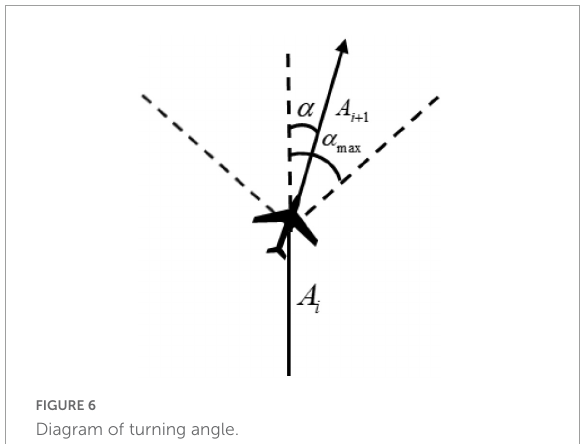
FIGURE6 Diagram of turning